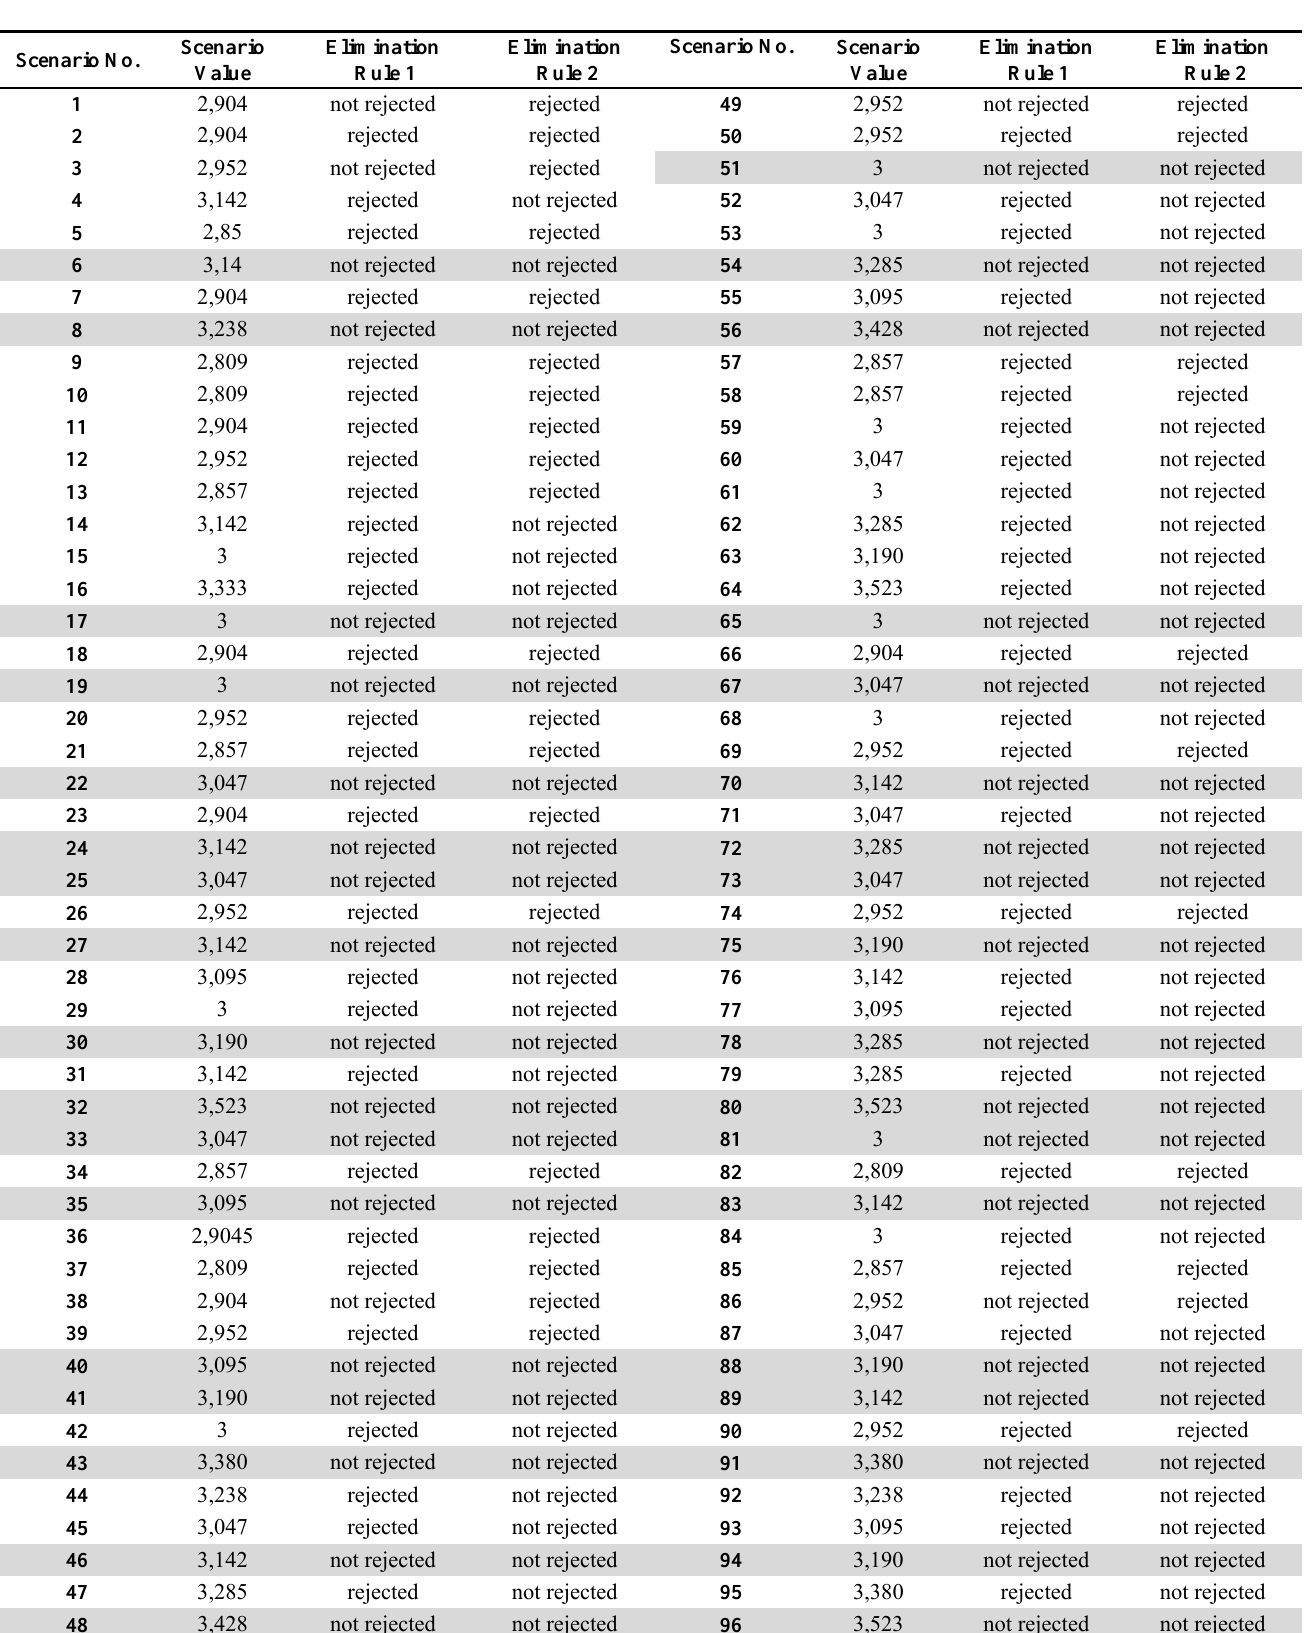
Table 4: Eliminating the incompatible scenarios Scenario